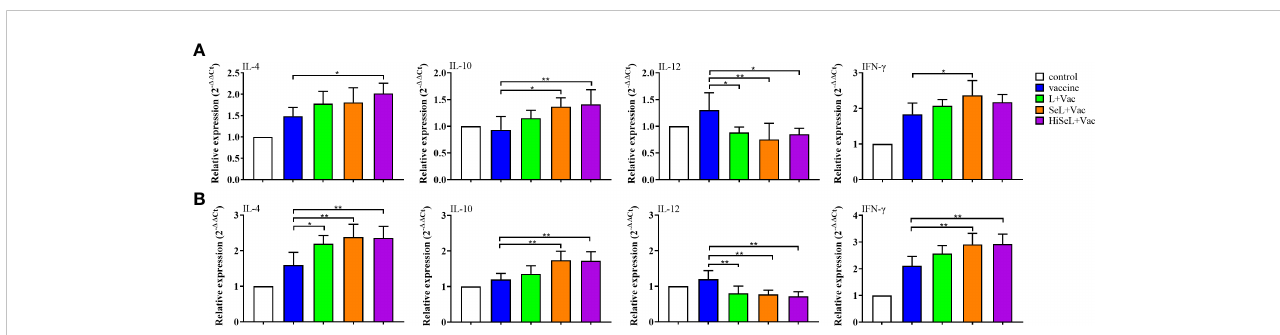
FIGURE 4 Effect of SeL and HiSeL on the expression of cytokine genes related to SIgA induced by the immunization of mice. Jejunal tissue samples of mice were gathered on days 1 and 28 after immunization to detect cytokine genes related to SIgA. (A) Results of mRNA level of cytokines in jejunal cells on the fi rst day after immunization. (B) Results of mRNA level of cytokines in jejunal cells on the 28th day after immunization. Each experimental group consisted of fi ve mice per group. Data were presented as means ± SD ( *P < 0.05, and **P < 0.01). The statistical analysis was performed using one-way